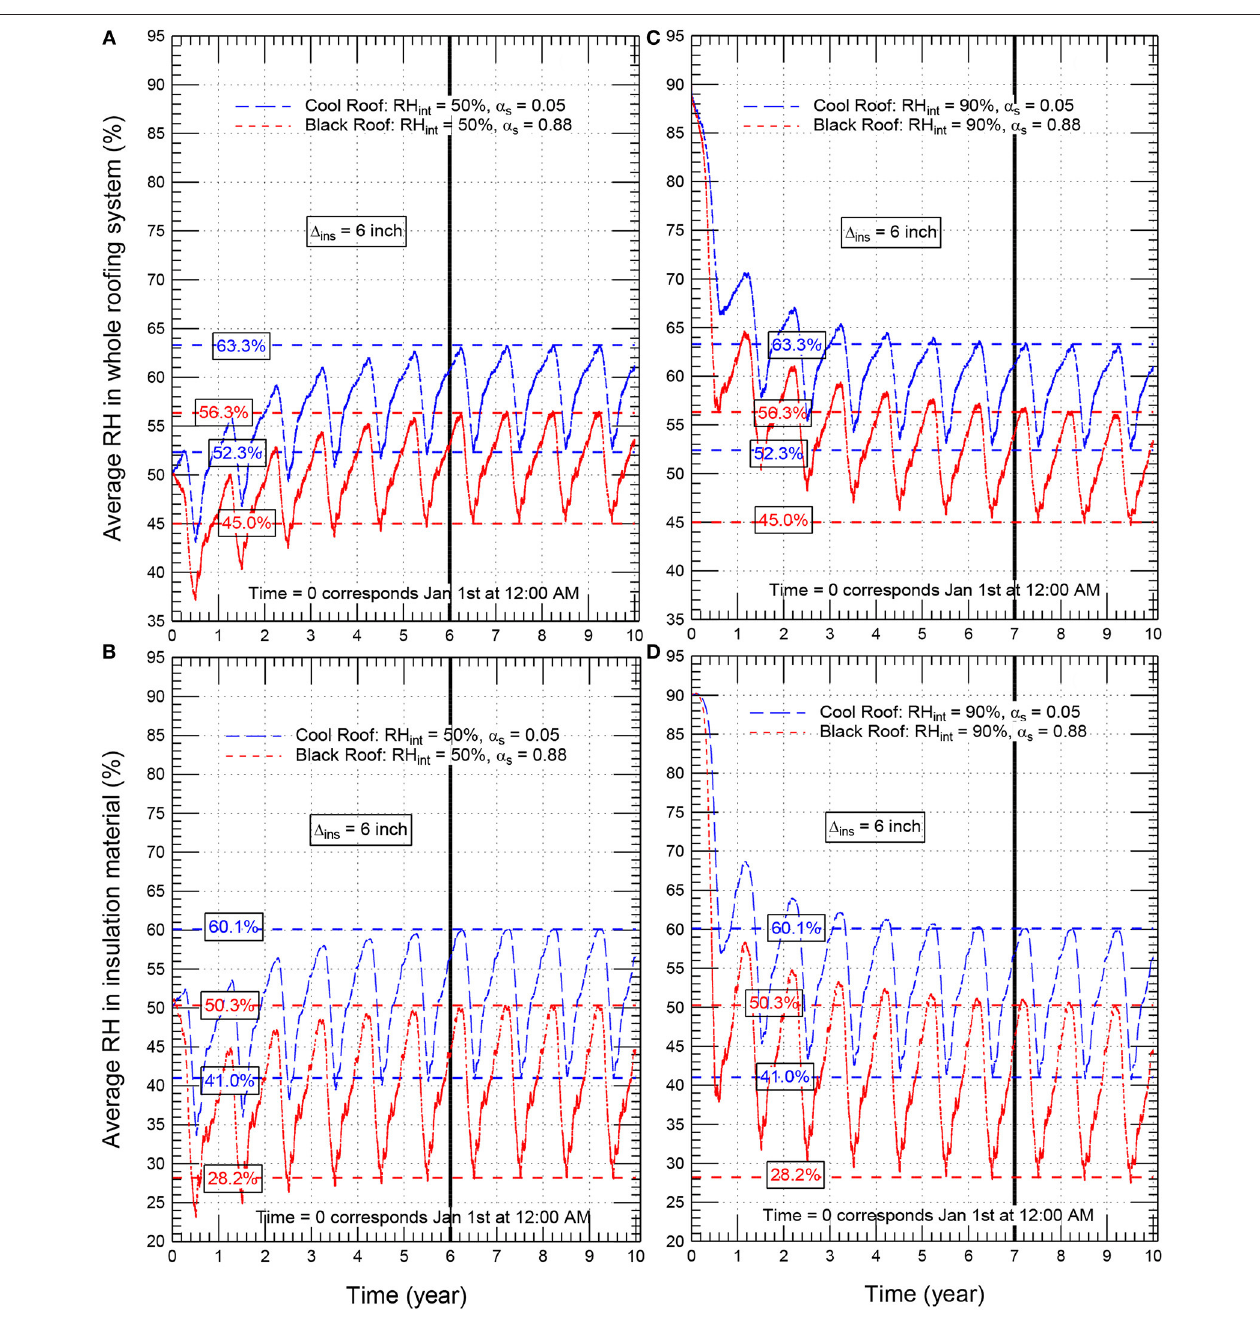
FIGURE 6 | Average hourly relative humidity in the whole roof (A,C) and the insulation material (B,D) of conventional/black roof ( α s = 0.88) and cool roof ( α s = 0.05) for 1 ins = 152mm (6.0